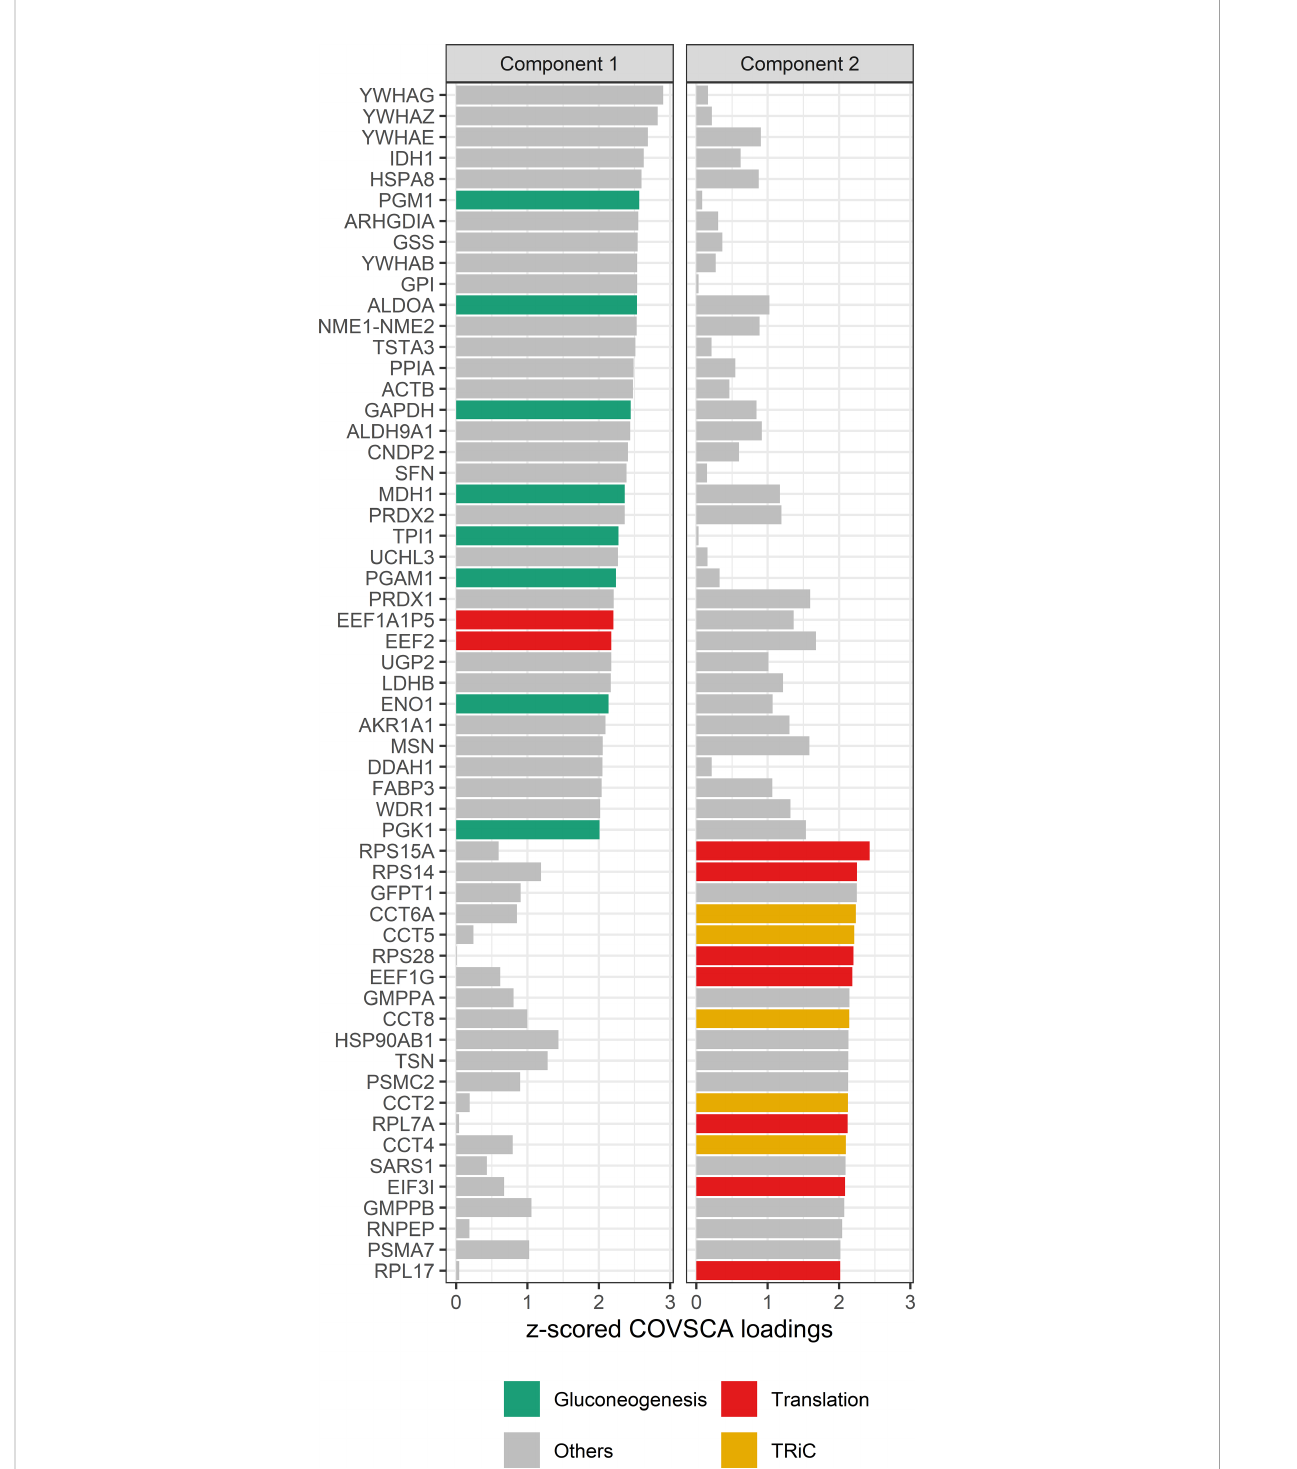
FIGURE 8 COVSCA loadings of the COVSCA model of different groups based on maternal and child allergy status in the CHILD Cohort Study. Loadings indicate the importance of each protein for the differences or similarities in correlation patterns observed in the COVSCA score plot (Figure 7). Proteins are labeled with gene IDs along the y-axis, and colors indicate shared gene ontology annotations. Among the proteins important for explaining the variability between the networks are proteins involved in gluconeogenesis, translation, and the tailless complex polypeptide 1 ring complex